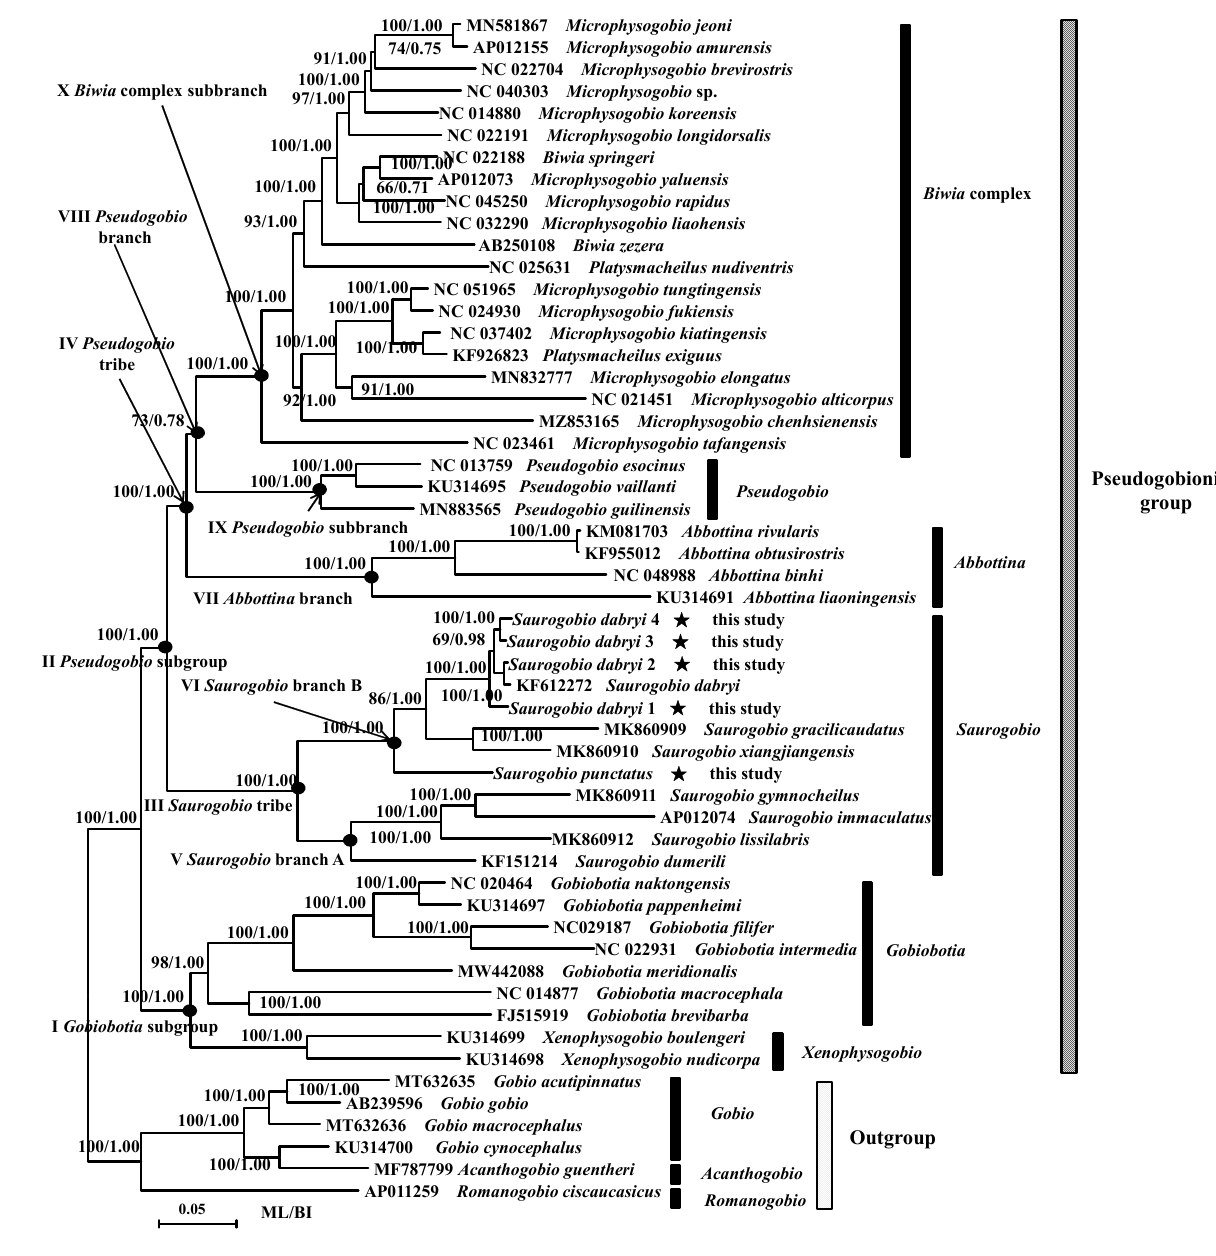
Figure 1. Phylogenetic relationships of the Pseudogobionini group in ML and BI analysis based on the concatenated nucleotide sequences of 13 PCGs. Numbers on nodes before/after represent bootstrap values and posterior probabilities, respectively. The asterisks ( ★ ) represent sequences determined in this study. The black dots ( ● ) indicate that nodes were used for selection pressure analysis. Definitions of the classification system and sequences of GenBank accession numbers were shown in the figure. Saurogobio branch A contains four species: S. dumerili , S. immaculatus , S. lissilabris , and S. gymnocheilus ; Saurogobio branch B includes four species: S. dabryi , S. gracilicaudatus , S. xiangjiangensis , and S. punctatus .